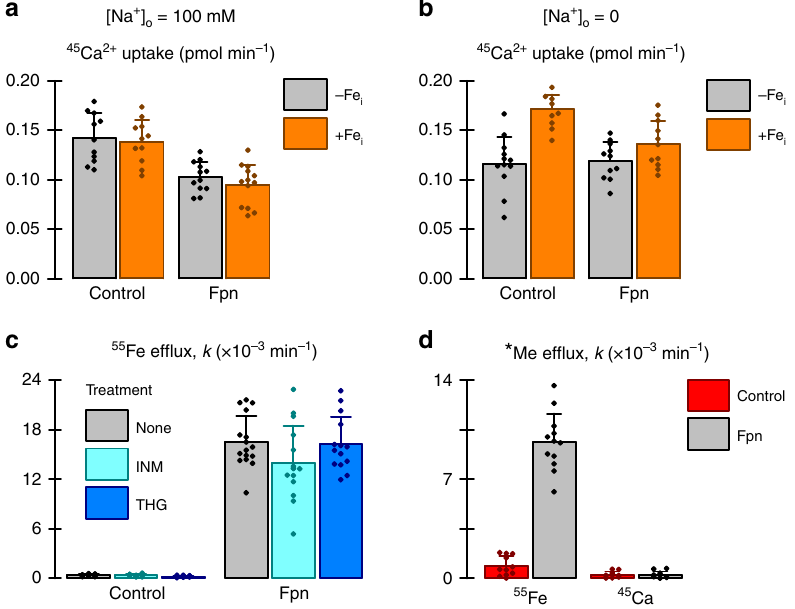
Fig. 3 No evidence to support that calcium is a transported substrate of Fpn. a Uptake of 100 μ M 45 Ca 2 + in control oocytes and oocytes expressing Fpn that were injected with either vehicle alone ( − Fe i ) or 50 nl of 50 µ M Fe ( + Fe i ) ( n = 12, 12, 13, 14, left to right). Two-way ANOVA: no interaction ( P = 0.70). b Uptake of 100 μ M 45 Ca 2 + in control oocytes and oocytes expressing Fpn in the absence of extracellular Na + (Na + was replaced by choline) ( n = 12, 8, 11, 12). Oocytes were injected with either vehicle alone ( − Fe i ) or 50 nl of 50 µ M Fe ( + Fe i ). Two-way ANOVA: interaction ( P = 0.008); within Fpn, + Fe i did not differ from − Fe i ( P = 0.069). c Effect of 1 µ M ionomycin (IMN) or 2 µ M thapsigargin (THG) on 55 Fe ef fl ux ( n = 15, 14, 14, 16, 15, 14). All media contained 0.2% DMSO. Two-way ANOVA: no interaction ( P = 0.13). d Ef fl ux of 55 Fe or 45 Ca ef fl ux from control oocytes and oocytes expressing Fpn ( n